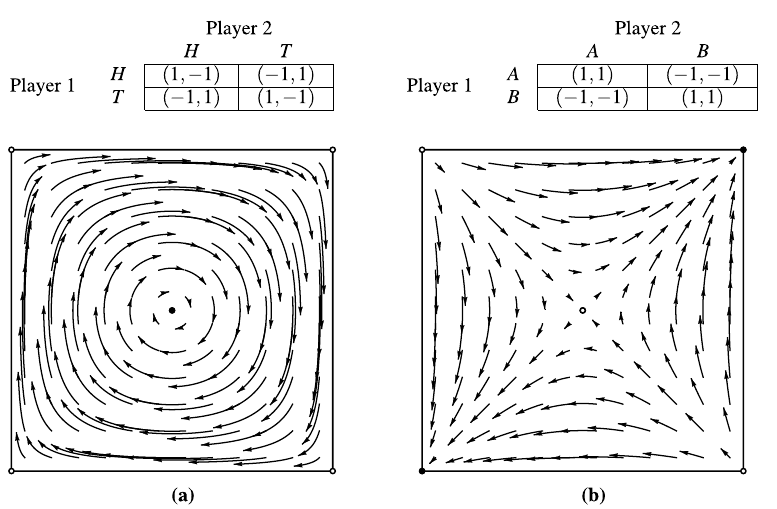
Figure 4. Canonical game payoffs and replicator dynamics trajectories. Each point encodes the probability assigned by the players to their first strategy. The matching pennies replicator dynamics have one chain component, consisting of the whole domain. The coordination game dynamics have five chain components (corresponding to the fixed points, four in the corners and one mixed, which are recurrent by definition), as was formally shown by 26